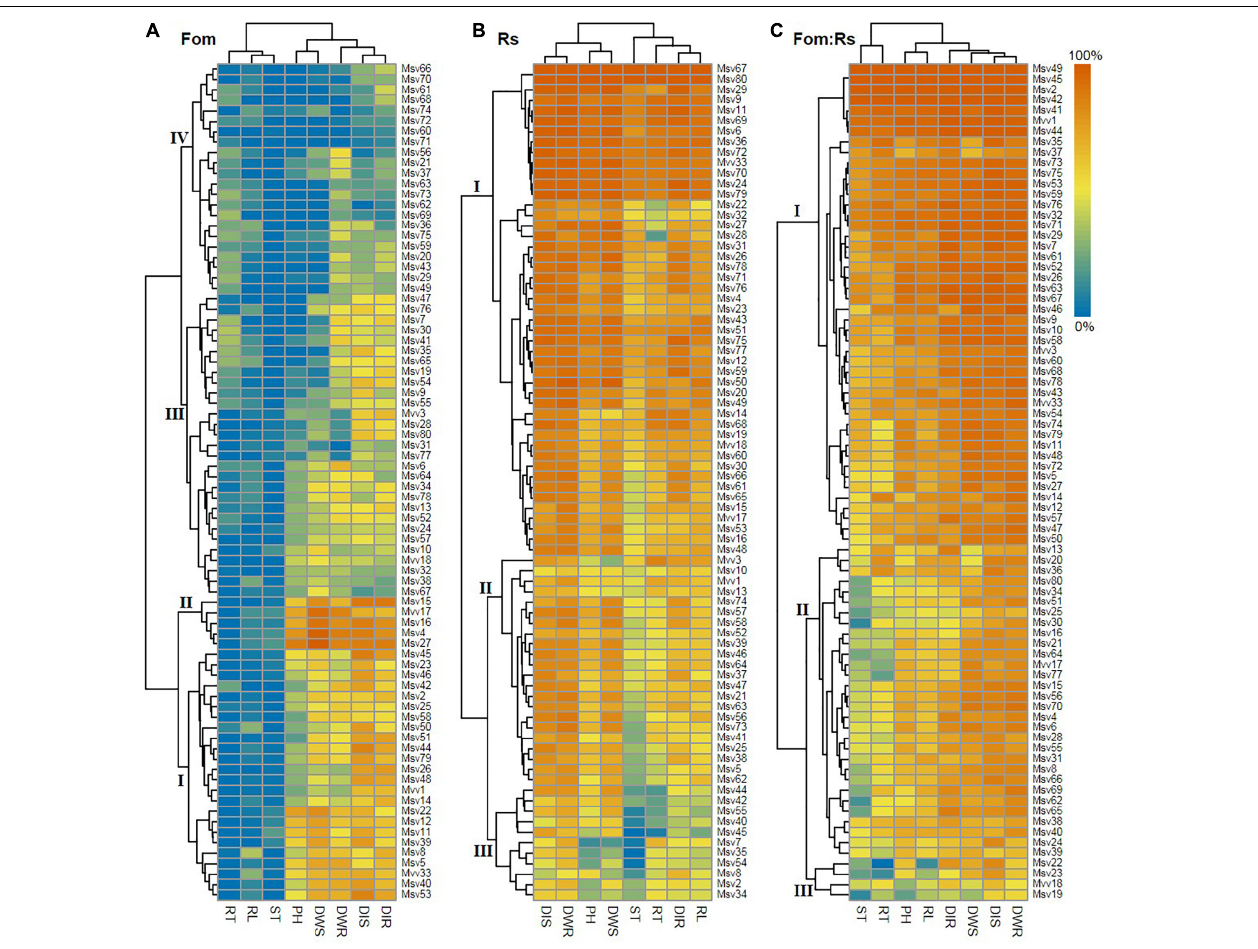
FIGURE 6 | Hierarchical clustering of 80 alfalfa varieties based on variations in pathogen effect sizes of all plant traits single and co-inoculated with Fom and Rs. (A) Single inoculation with Fom (Fom), (B) single inoculation with Rs (Rs), and (C) co-inoculation with Fom and Rs (Fom:Rs). Labels on the dendrogram (I, II, III, and IV) represent the main groups. The heat map shows variations in pathogen effect sizes of different traits. The color gradient range (0–100%) is shown on the top right corner. Positive effects (effect size < 0) of pathogen treatment on some traits ( Supplementary Figures 1–4 ) were defined as zero to maximize resolution. DIS and DIR, disease index of plant shoot and root, respectively; PH, plant height; RL, root length; DWS and DWR, dry weight of shoot and root, respectively; ST, shoot biomass ratio; RT, root biomass